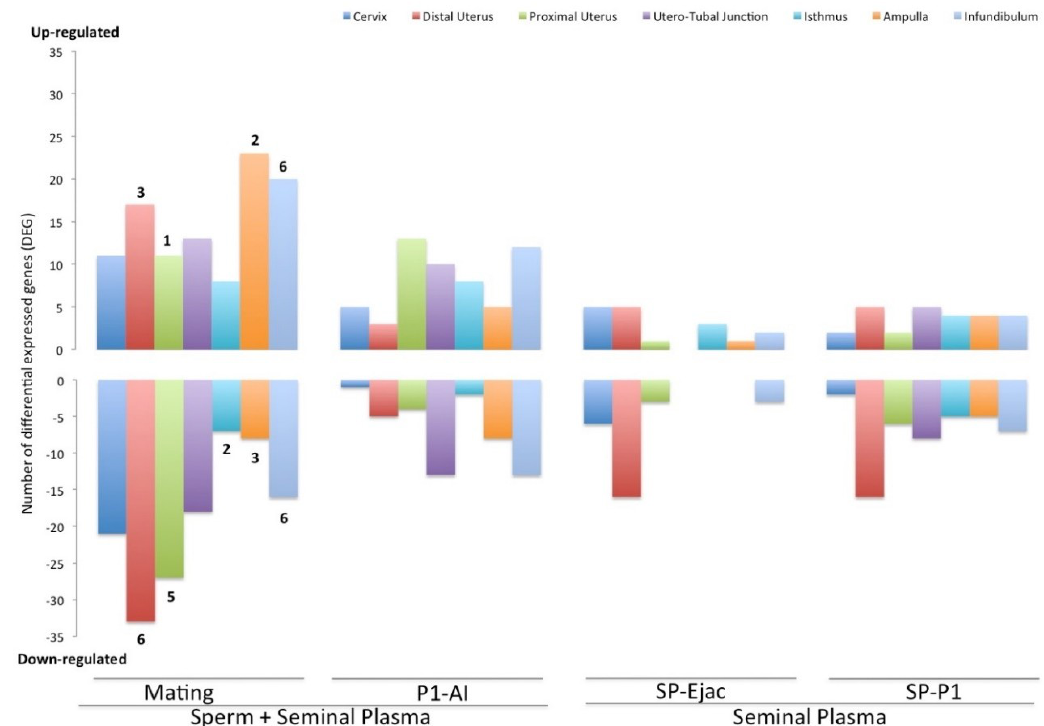
Figure 1. Distribution of differentially expressed annotated genes belonging to pathways of the immune function process (GO:0002376), up- and down-regulated ( p < 0.05) along segments of the internal female genital tract (Cervix to Infundibulum) after the different treatments (Mating: sow mated with a boar; P1-AI: sow artificially inseminated with the sperm-peak portion (P1) extended to 50 mL with Beltsville Thawing Solution (BTS); SP-Ejac: sow cervically infused with sperm-free SP of the whole ejaculate (50 mL); SP-P1: sow cervically infused with sperm-free SP from pooled sperm-peak portion P1 (50 mL). All treatments were compared to Control (cervical infusion with 50 mL of BTS). The numbers of false discovery rate (FDR)-corrected ( q -value < 0.05) genes are presented over/under bars in the mating treatment.